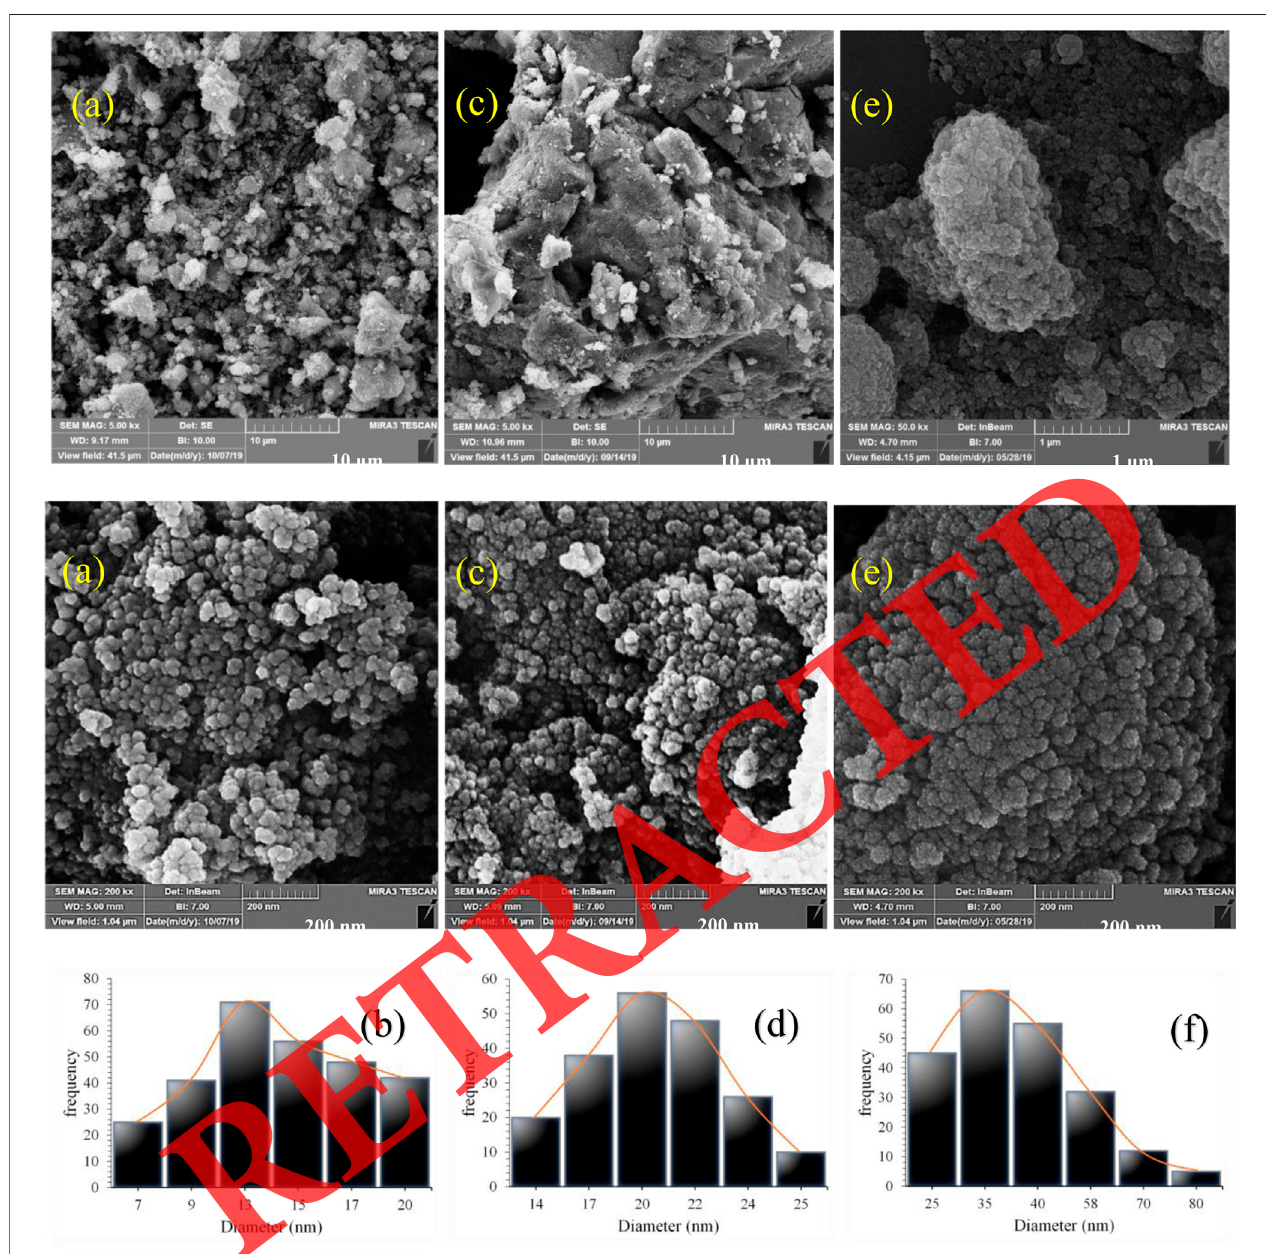
FIGURE9| Field emission-scanningelectron microscopy images and dynamiclightscattering resultsof (A, B) Fe 3 O 4 , (C,D) Fe 3 O 4 @CNF, and (E, F) Fe 3 O 4 @CNF ∼ ImSBL ∼ Co. complex nanocomposite.